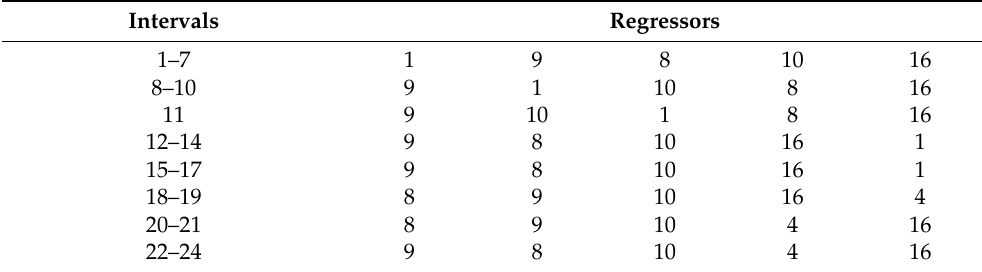
Table 2. Lists of regressors in descending order of correlation on 10-h non-overlapping observation intervals.